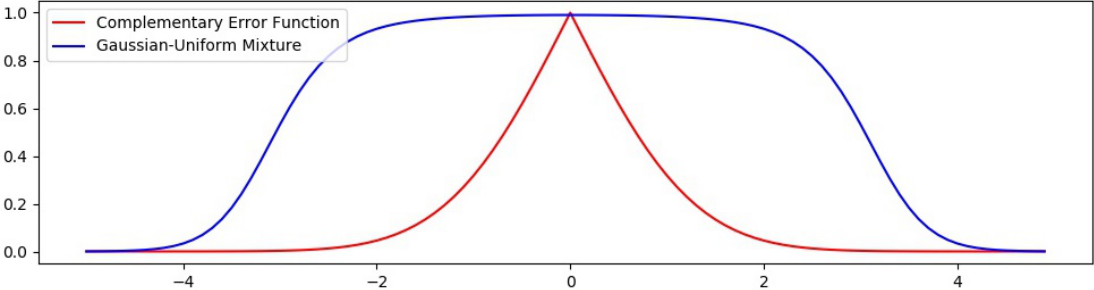
Figure 5. Comparison of the Complementary Error Function and the Gaussian-Uniform Mixture densities with σ =